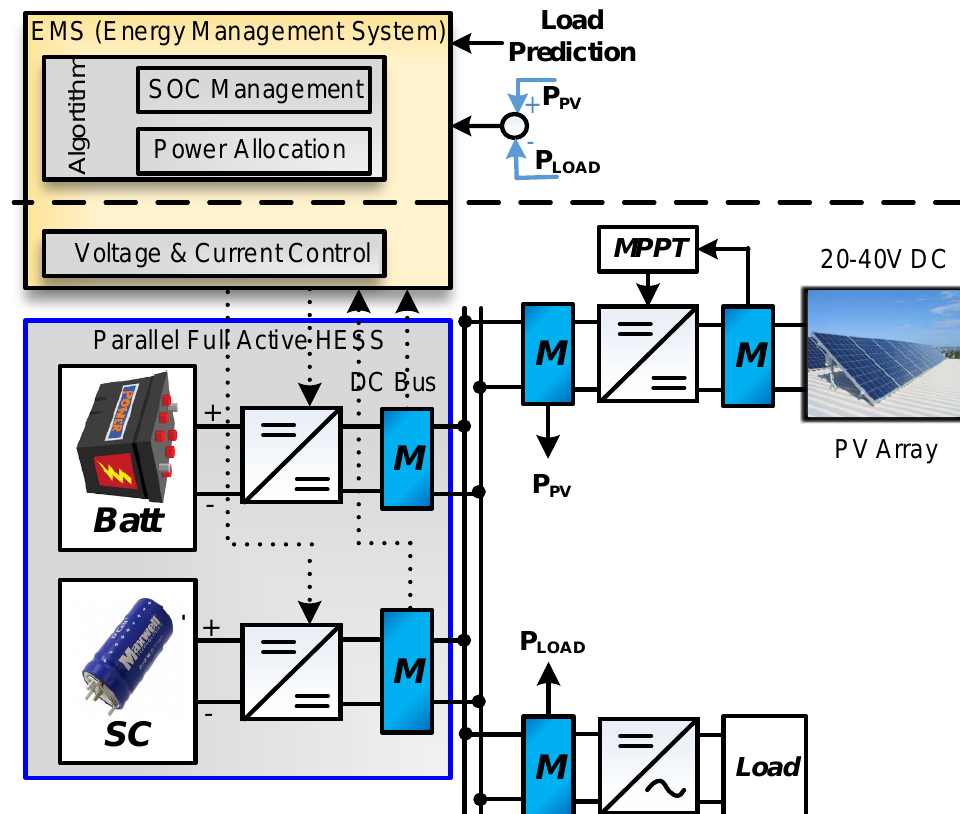
Figure 1. Typical autonomous PV-HESS grid system for rural electrification.